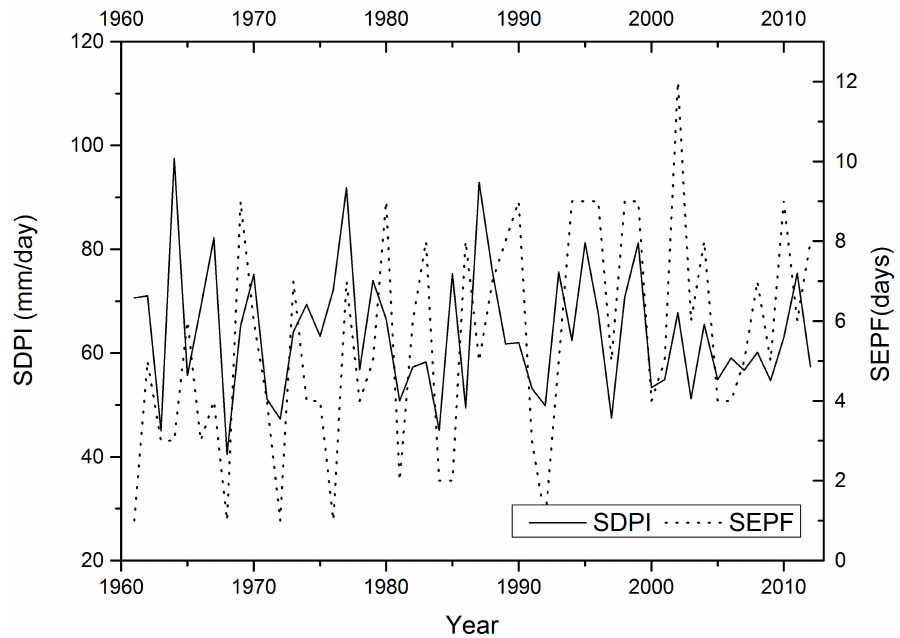
Figure 11. Interannual variations of SDPI and SEPF at the Yueyang station in Poyang-Changjiang area from 1961 to 2012.